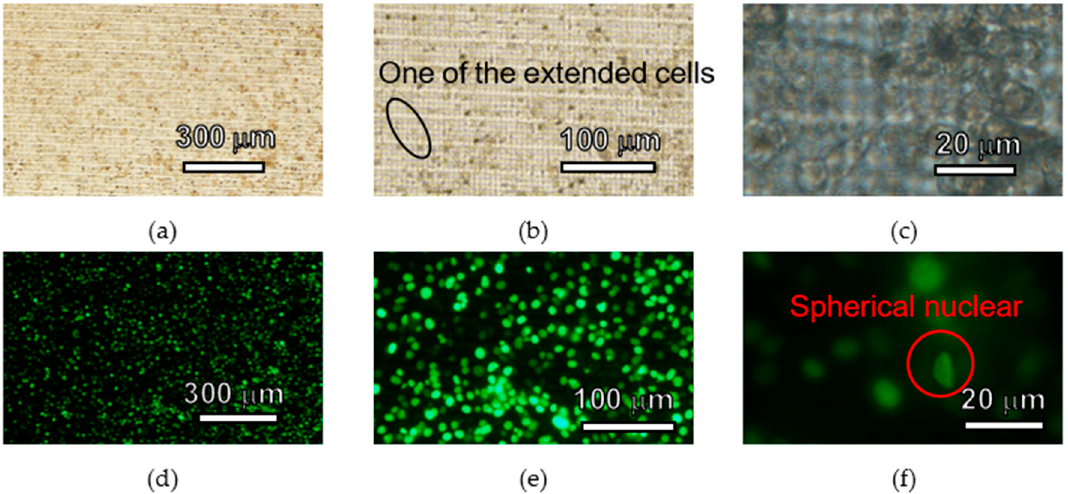
Figure 7. Images of HeLa cells cultured 3 days on the cell culture plate. ( a ) Bright field (×40). ( b ) Bright field (×100). ( c ) Bright field (×400). ( d ) Fluorescent (×40). ( e ) Fluorescent (×100). ( f ) Fluorescent (×400).